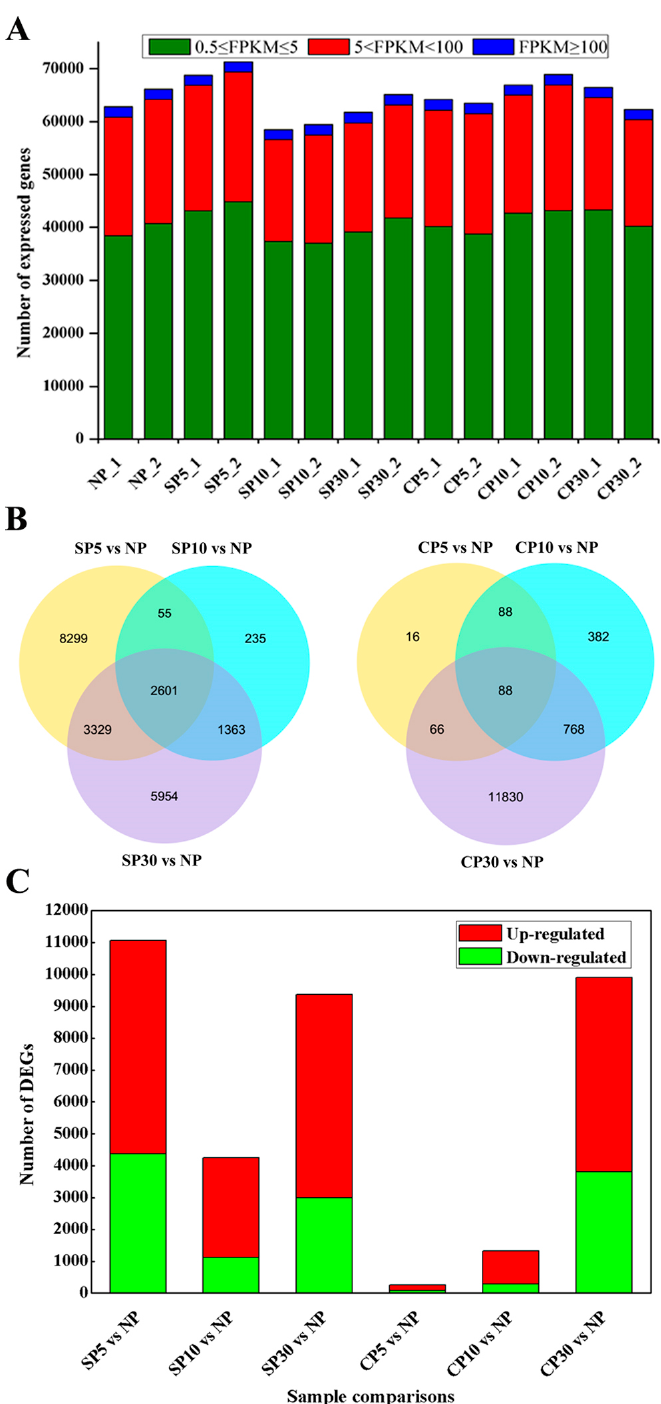
Figure 3. Global gene expression profiling of self- and cross-pollination in sheepgrass. ( A ) Numbers of genes expressed at di ff erent levels (based on FPKM) in the 14 samples of non-, self-, and cross-pollinated pistils. ( B ) Venn diagrams showing the numbers of di ff erentially expressed genes ( p -value ≤ 0.01) during each time course in self- and cross-pollinated pistils with respect to nonpollinated pistils. ( C ) Bar chart showing the number of upregulated (red) and downregulated (green) genes during each time course in self- and cross-pollinated pistils with respect to nonpollinated pistils. NP indicates nonpollinated pistils. SP5, SP10, and SP30 indicate self-pollinated pistils compared to nonpollinated pistils at 5 min, 10 min, and 30 min, respectively. Similarly, CP5, CP10, and CP30 indicate cross-pollinated pistils compared to nonpollinated pistils at 5 min, 10 min, and 30 min, respectively.